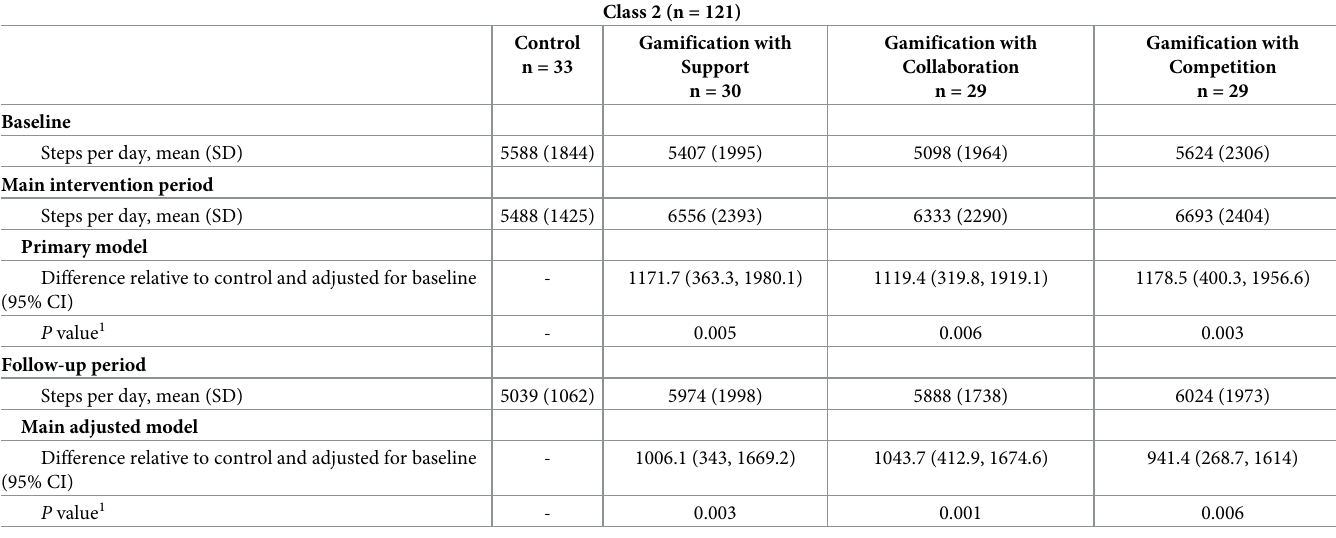
Table 4. Adjusted model of change in mean daily step count by intervention arm for class 2 (less active and less social).